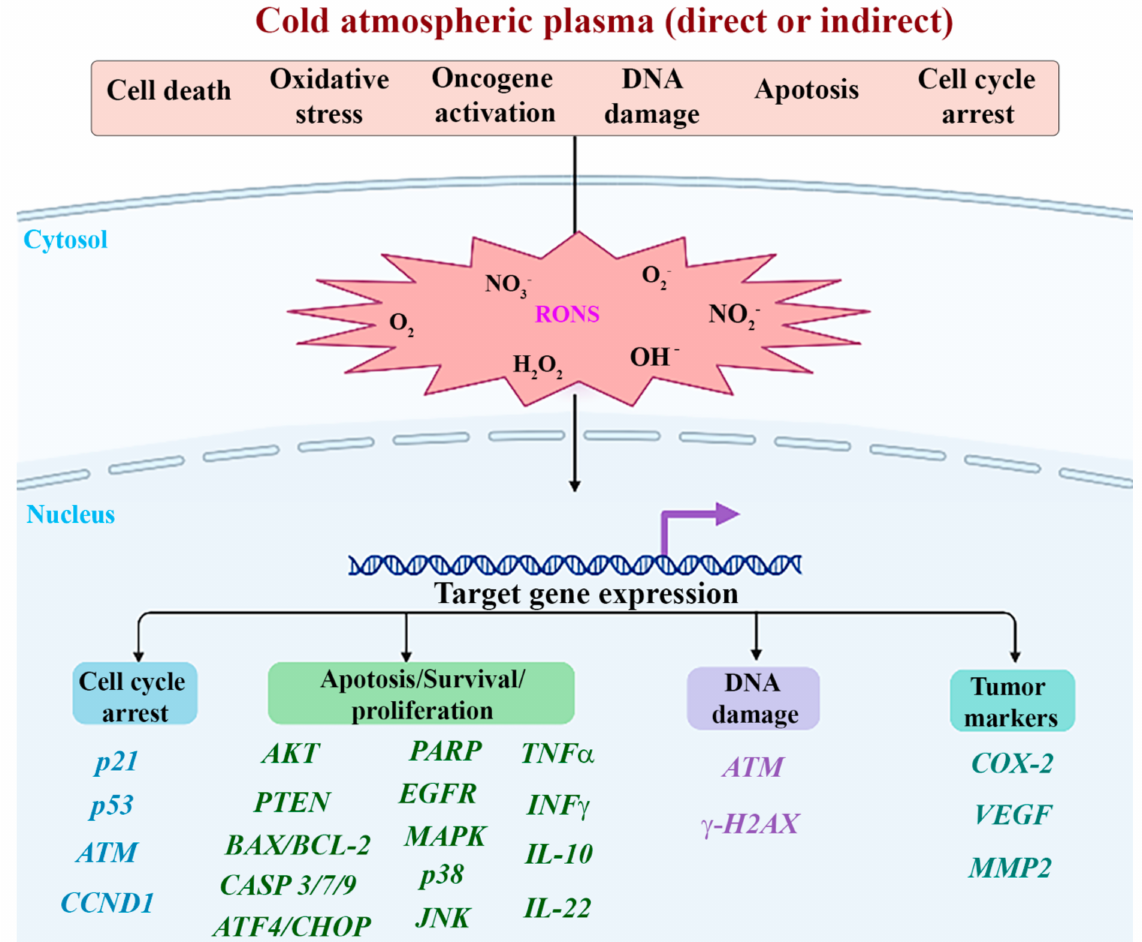
Figure 4. Molecular mechanisms induced by direct and indirect application of cold atmospheric plasma included in the present systematic